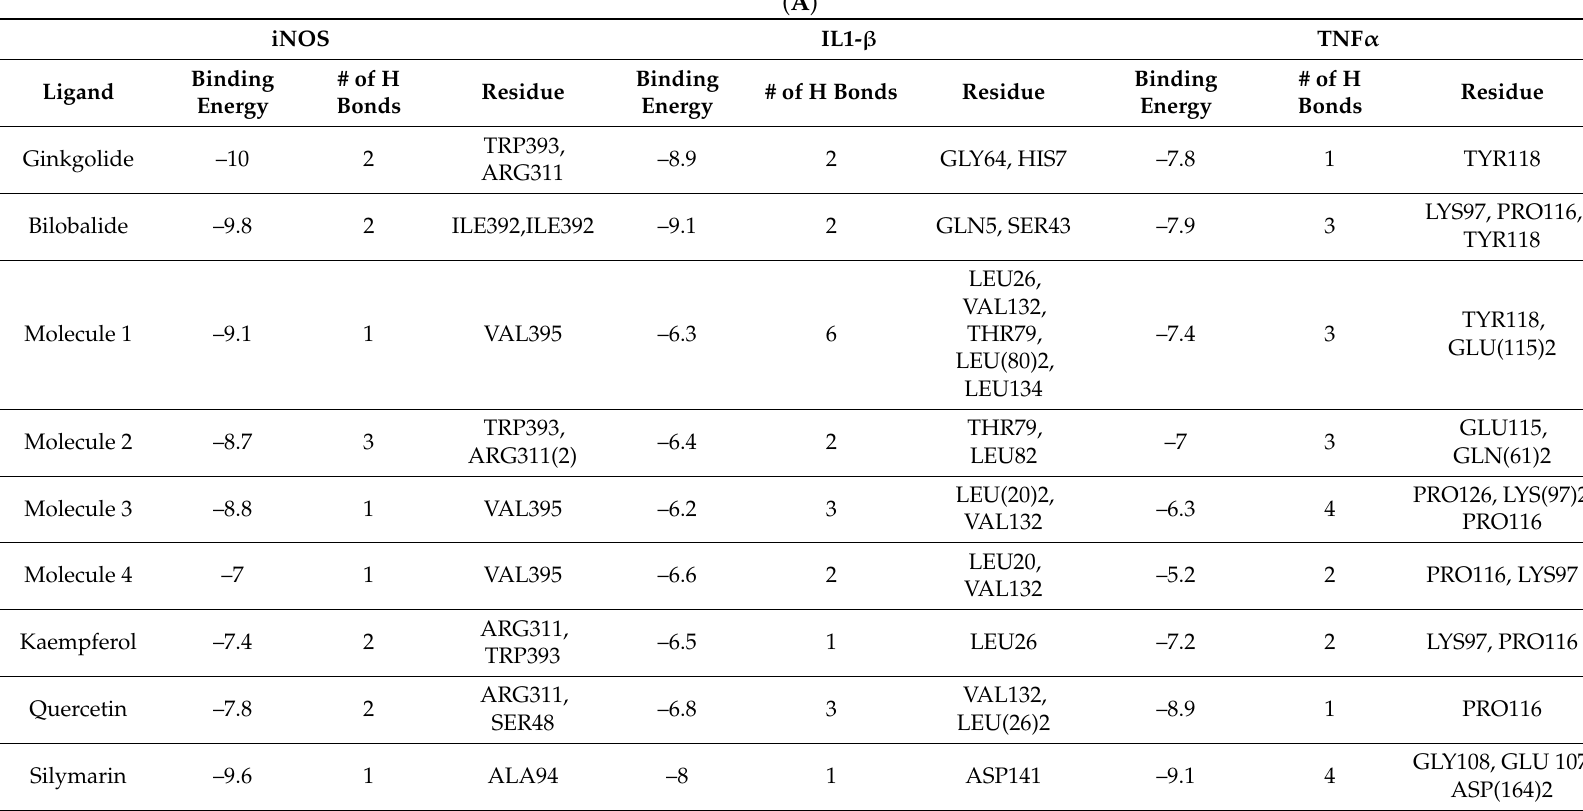
Table 5. Binding energy and amino acid residues involved in polar contacts between di ff erent ligands and IL1- β , TNF α , COX2, and TLR4. ( A